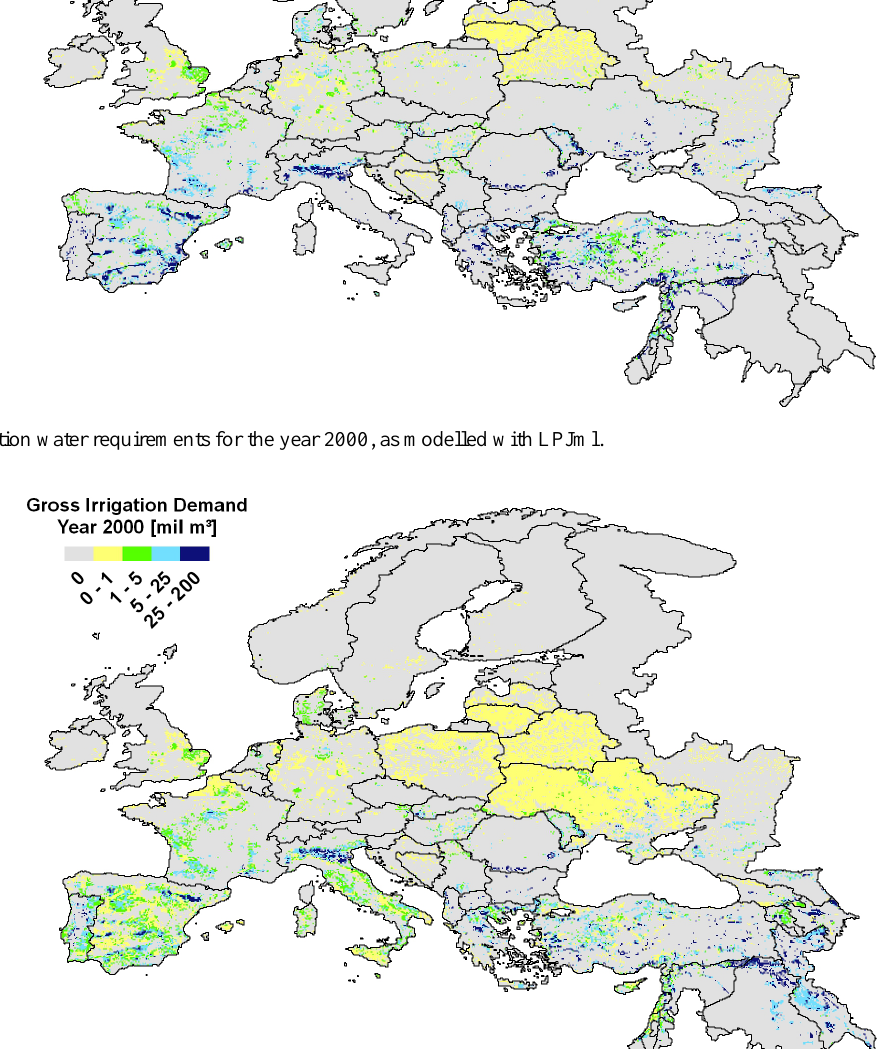
cereals, while AEI indicates 55%. This shows that the RIA concept is more reliable, not only in terms of irrigated area but also in terms of crop composition. Irrigation